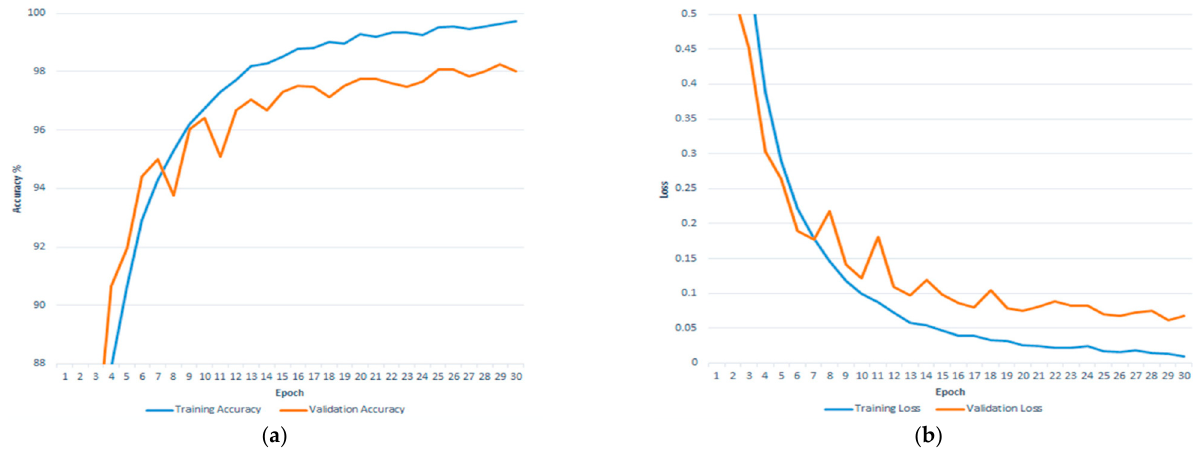
Figure 5. Performance analysis of Inception V4 model using PlantVillage dataset. ( a ) Model recog- nition accuracy; ( b ) train and test loss.